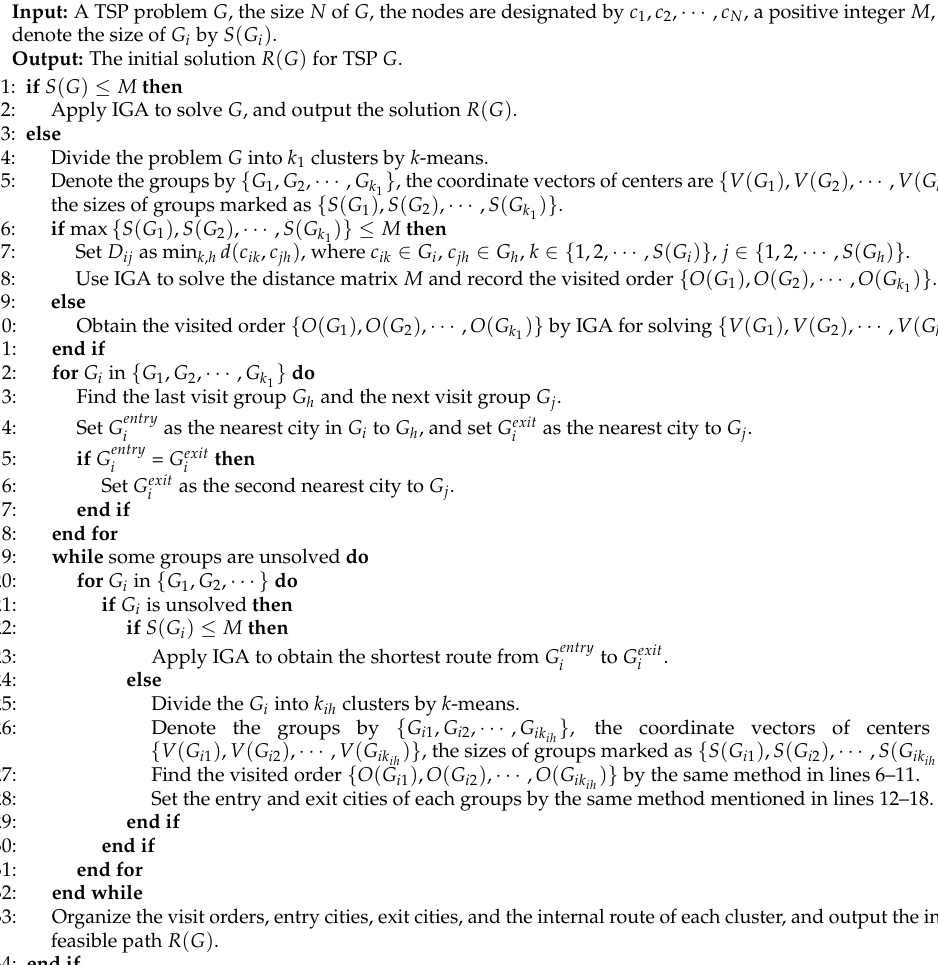
Algorithm 6 Solution initialization